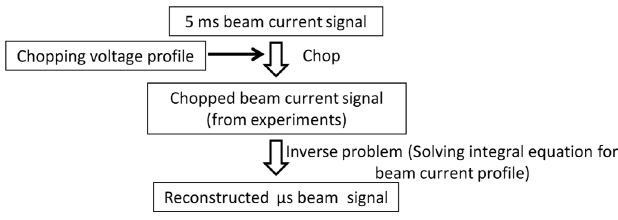
FIG. 16. Procedure of beam profile